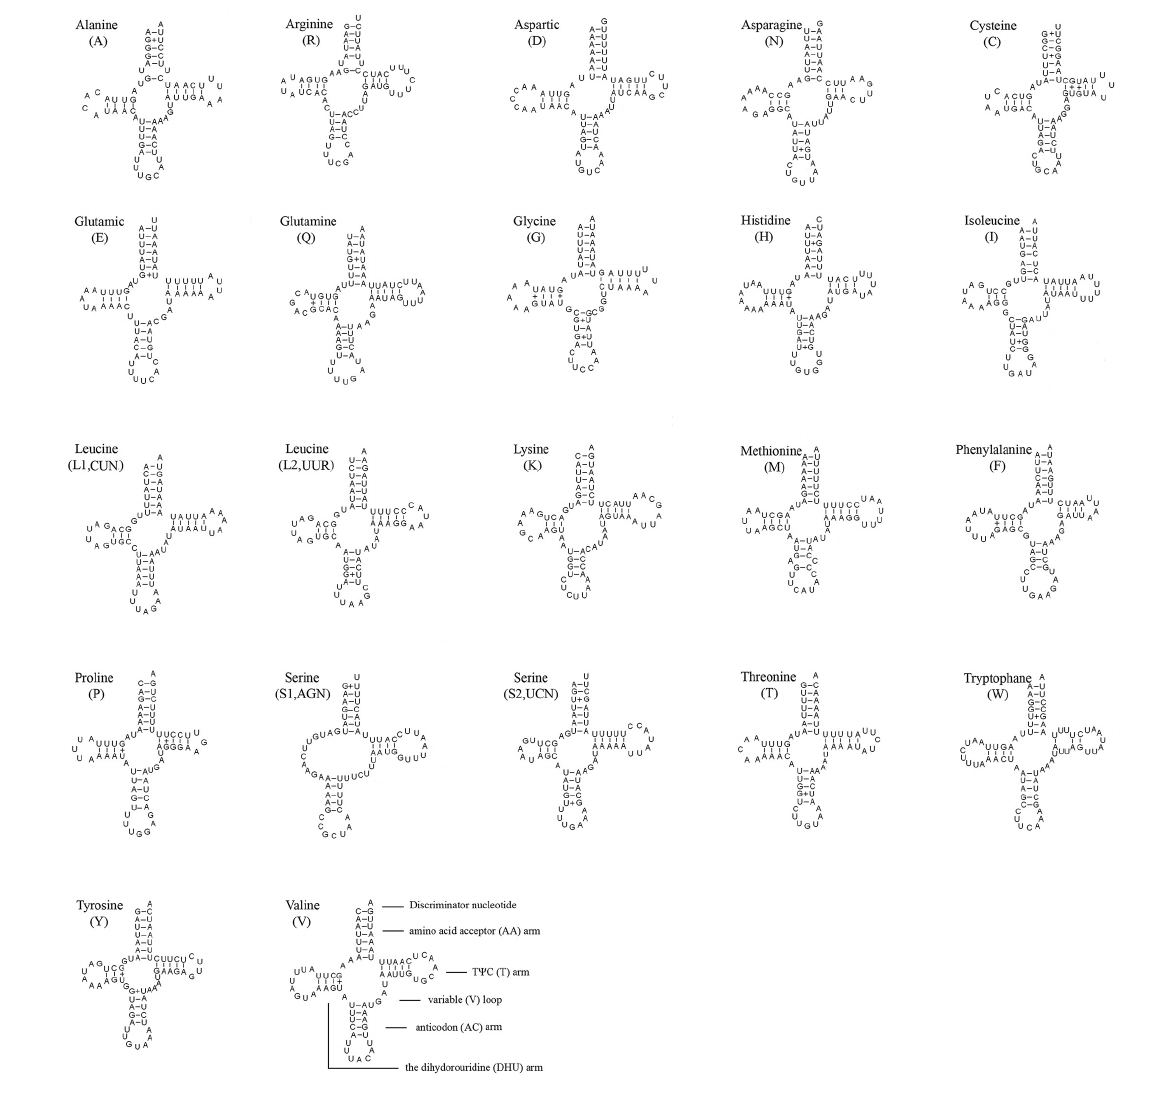
FIGURE4 Inferred secondary structure of 22 tRNAs of S. jisigouense . The tRNAs are labeled with the abbreviations of their corresponding amino acids. Inferred Watson-Crick bonds are illustrated by “–,” whereas GU bonds are illustrated by “+.”